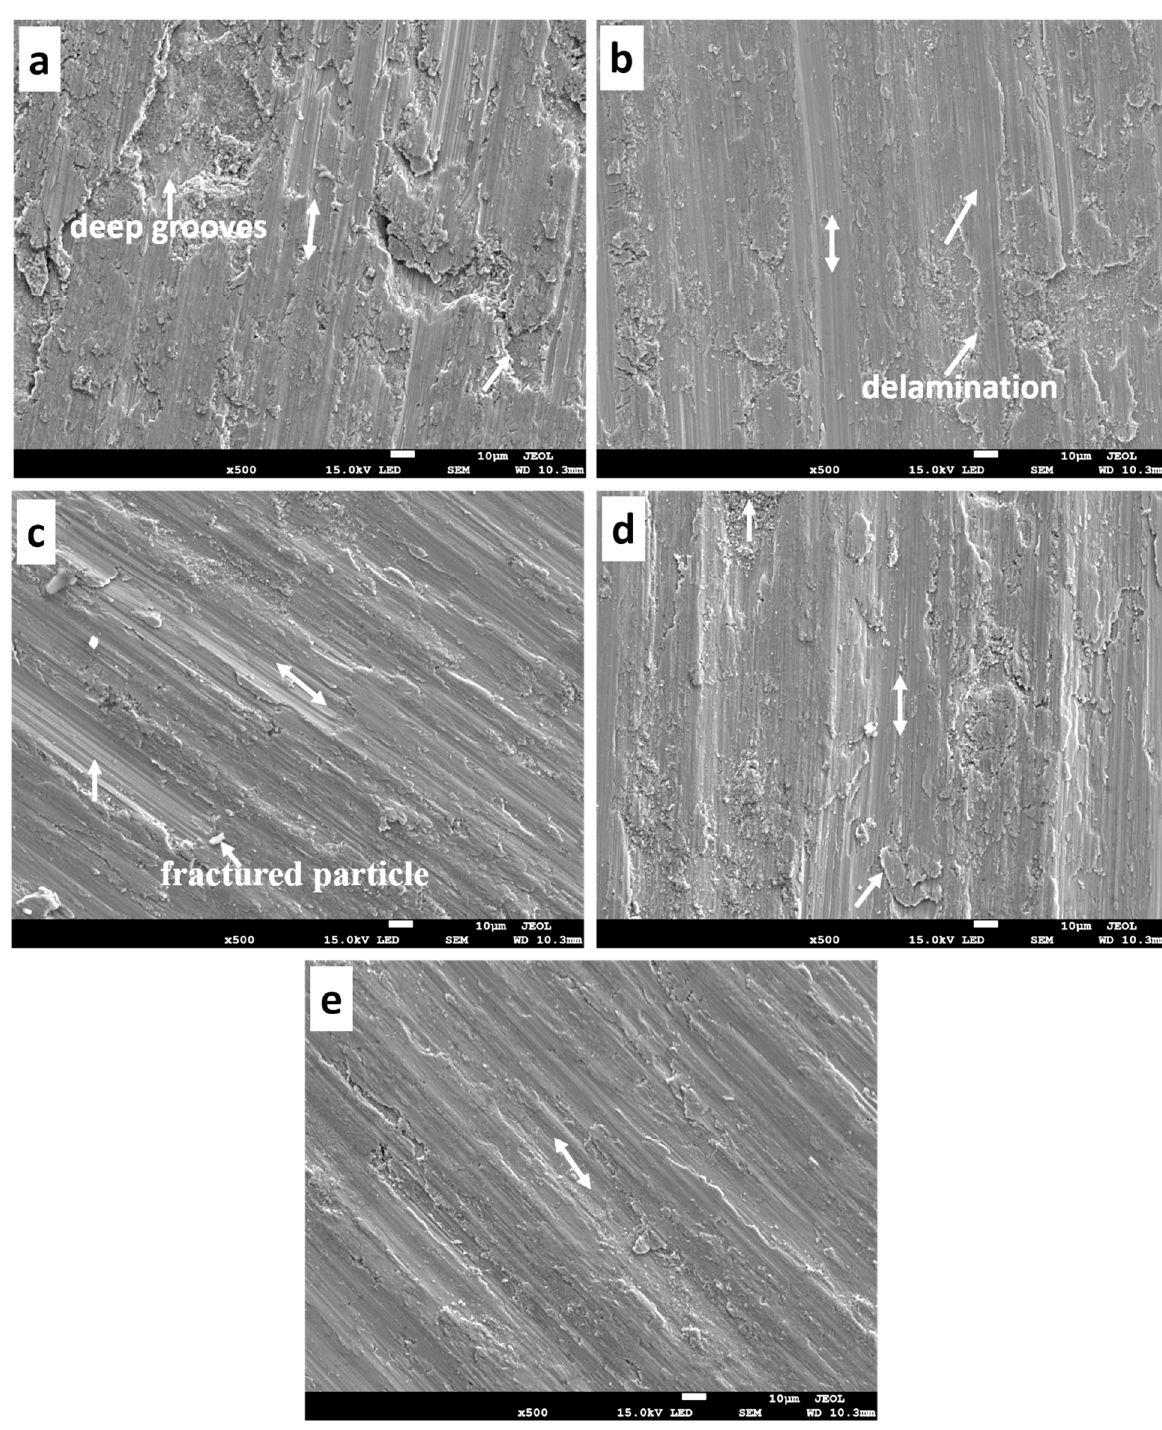
Figure 16. The worn surface of the sintered samples under 13 N ( a ) T0.0, ( b ) T2.5, ( c ) T5.0, ( d ) T7.5, and ( e ) T10.